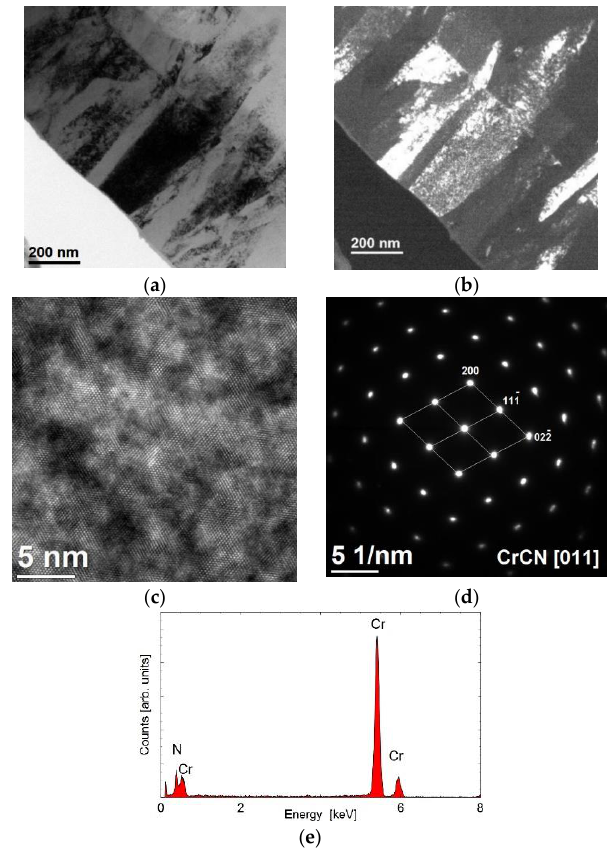
Figure 9. Structure of the CrCN layer: ( a ) TEM-BF image; ( b ) TEM-DF image based on the reflex (11-1); ( c ) HRTEM micrograph; ( d ) electron diffraction pattern; ( e ) result of the chemical composition analysis.